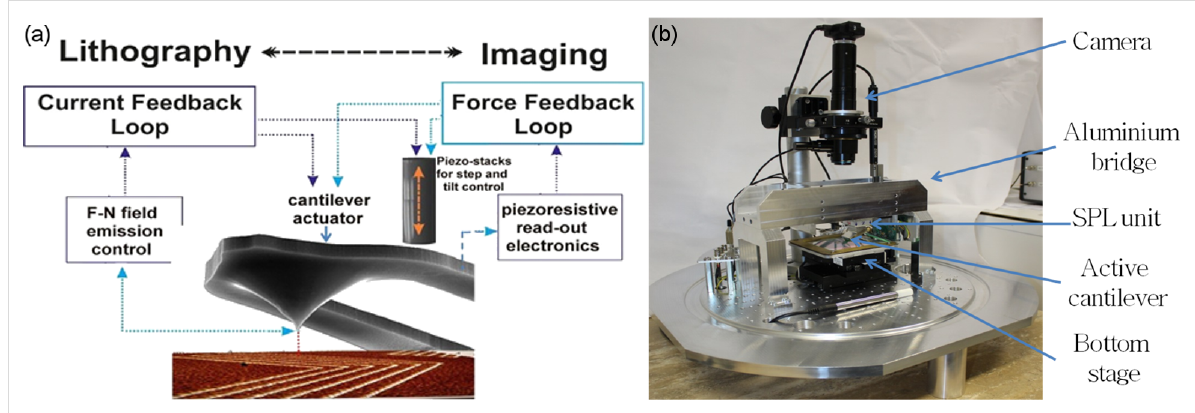
Figure 16: (a) Schematic showing feedback loops combined in FE-eSPL tool enabling lithography using the current feedback loop and measurement of written structures by AFM using the force feedback loop. Reprinted with permission from [157], copyright 2014 American Vacuum Society. (b) FE-eSPL tool developed in the Rangelow Group at TU Ilmenau. Reprinted with permission from [158], copyright 2018 Elsevier.